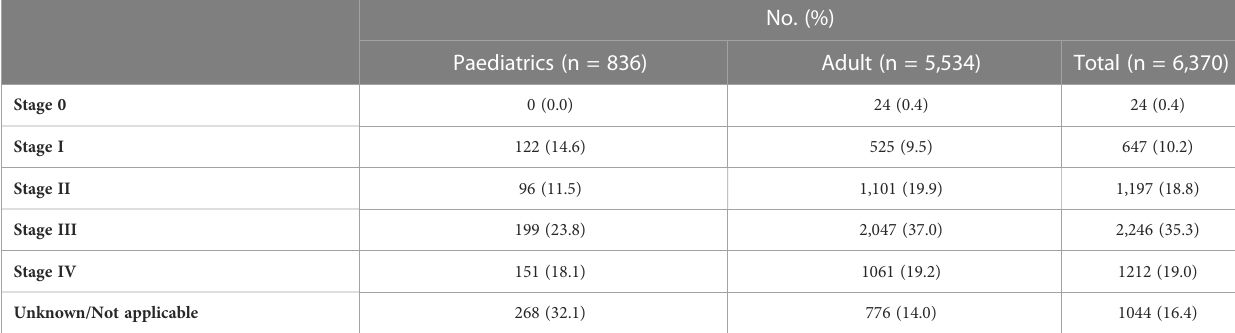
TABLE 1 Stage distribution among paediatric, adult, and total